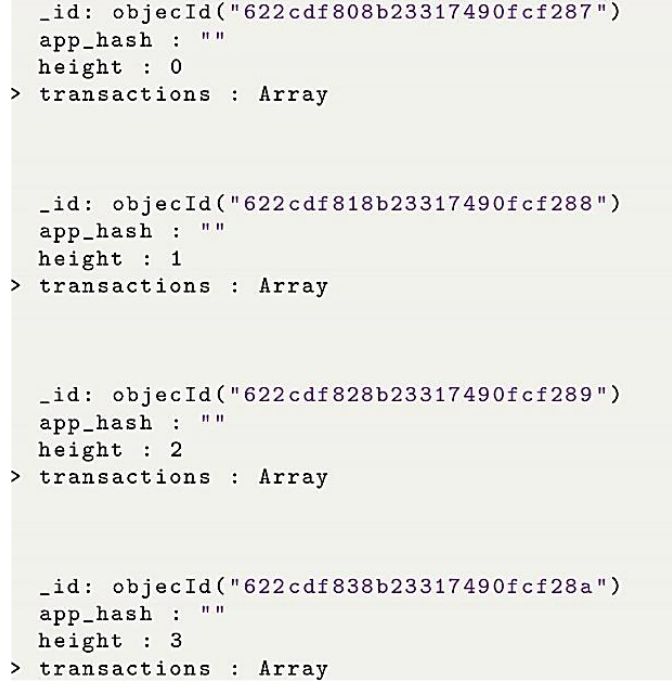
Figure 15. Block Enablement.